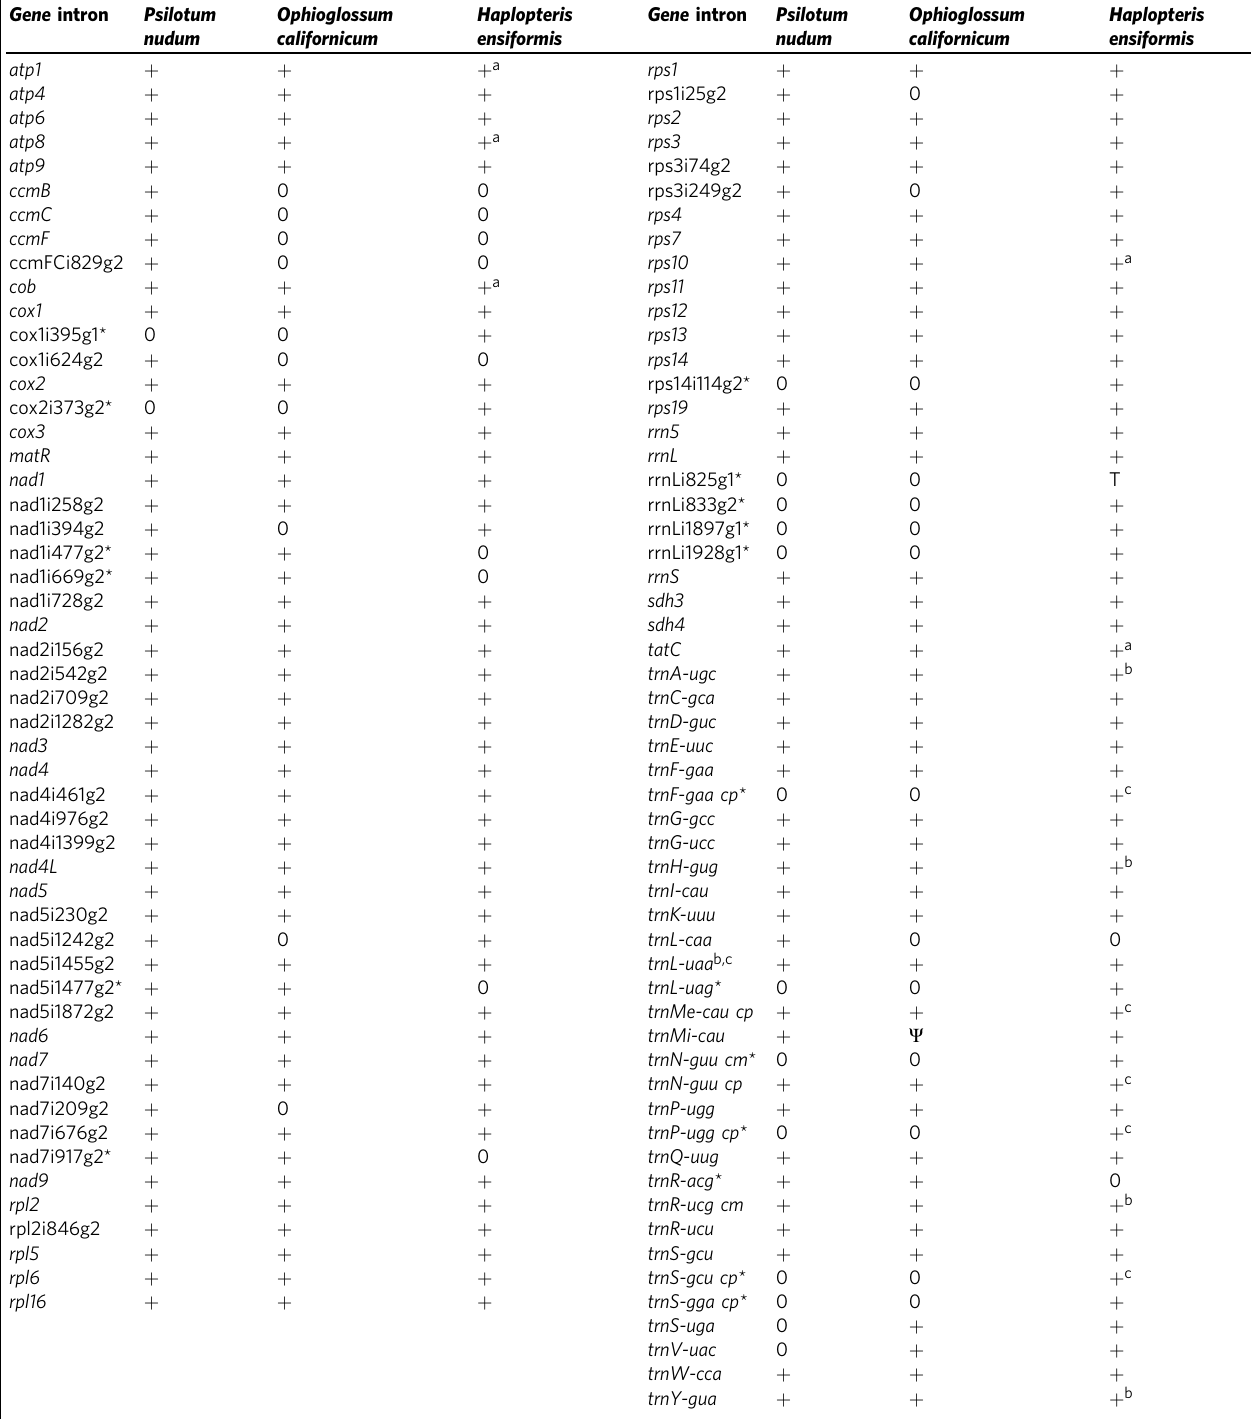
Table 1 The mitochondrial gene and intron complement of Haplopteris ensiformis